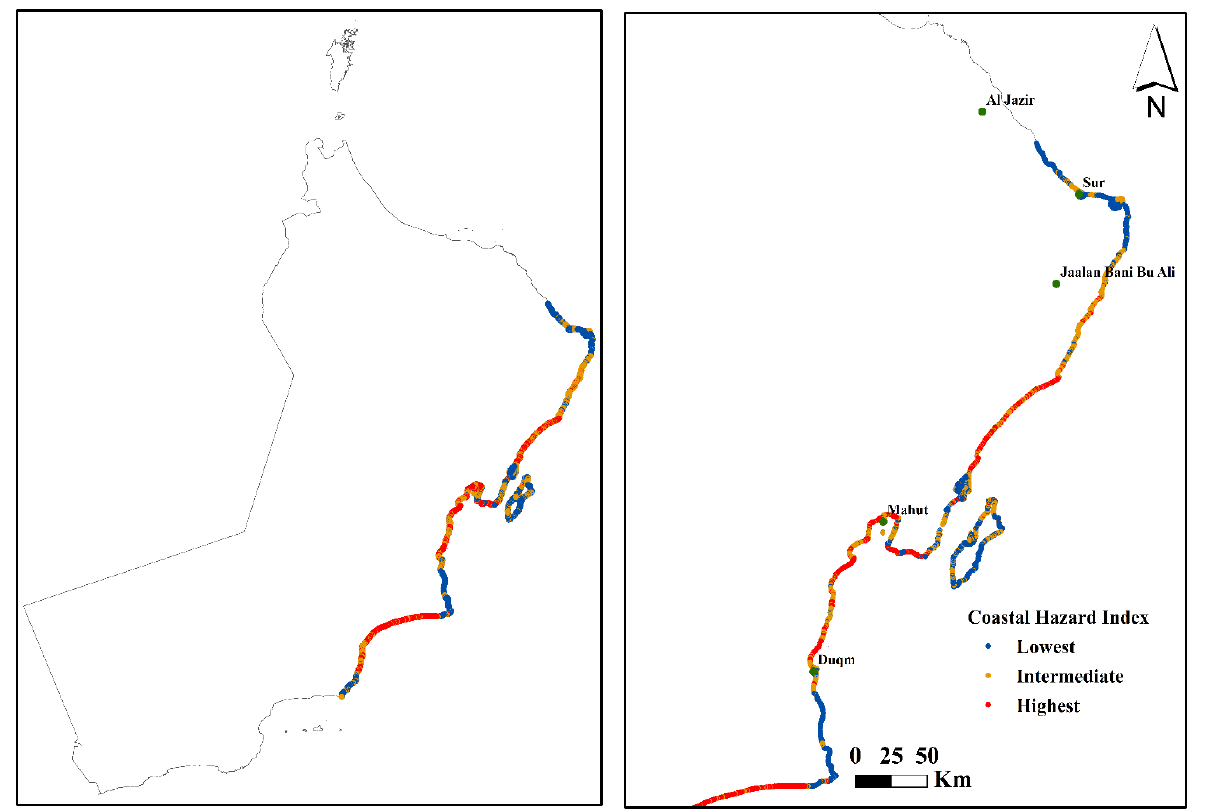
Figure 2. The study area’s relative exposure to coastal hazards. Storm surges and low-lying areas are the key drivers of coastal hazard exposure. the key drivers of coastal hazard